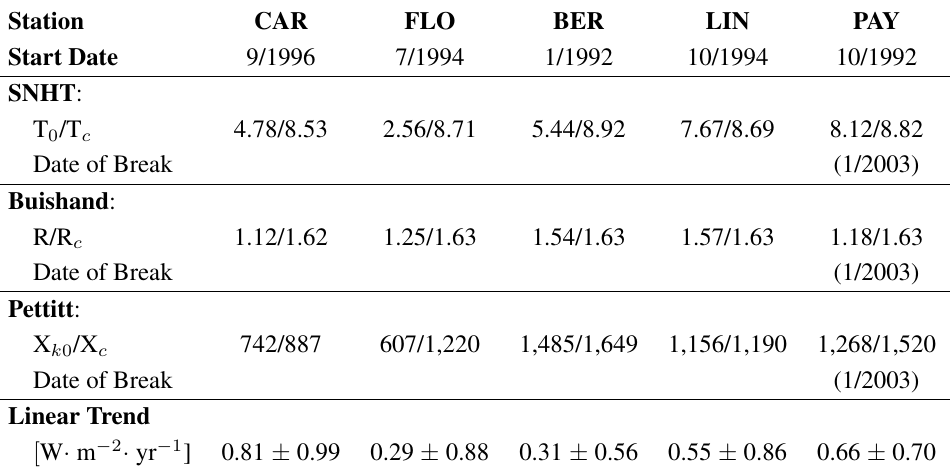
Table 4. Results of the absolute homogeneity testing of the CM SAF SIS dataset at the grid points nearest to the corresponding BSRN stations.